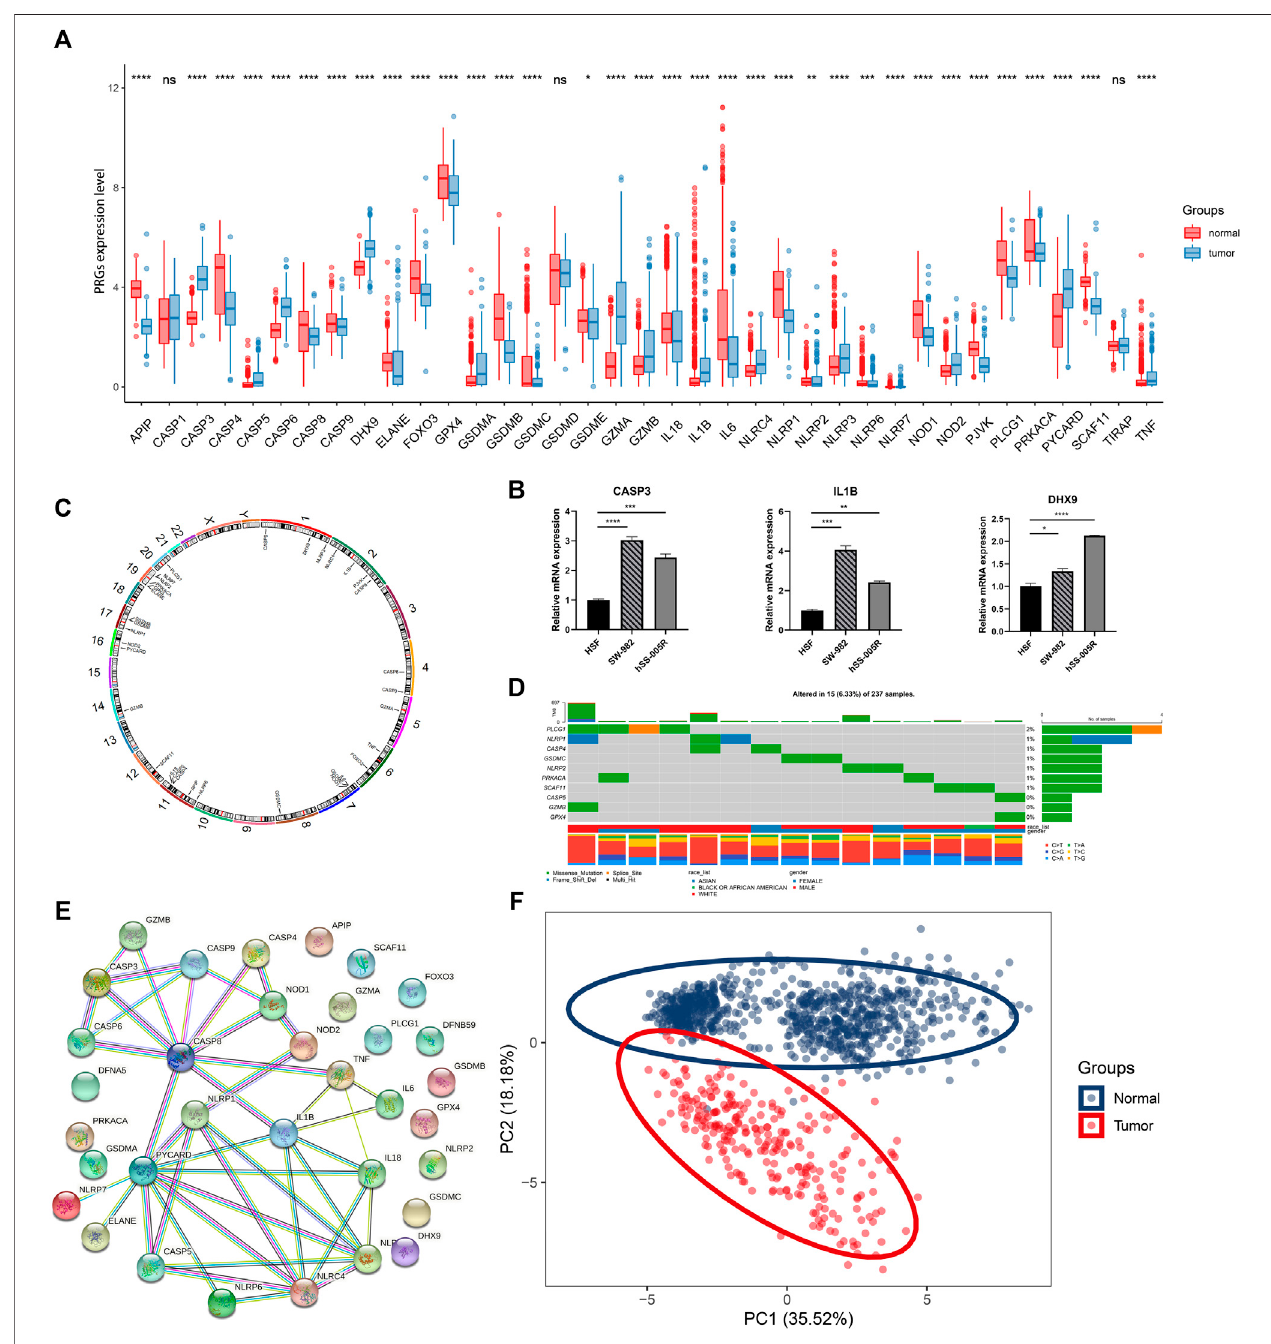
FIGURE 2 | Expression and association of PRGs. (A) The expression of PRGs between STS (blue) and normal tissues (red). Box plot represents the median (center horizontal line), upper and lower quartiles (top and bottom horizontal line). (B) Validation of mRNA expression of key PRGs in cell lines. (C) The location of PRGs on chromosomes. (D) Schematic overview of mutation frequency and type in PRGs. (E) PPI network constructed by PRGs-encoded proteins (interaction score: 0.9). (F) Principal component analysis (PCA) for discriminating STS and normal tissues based on PRGs. * p < 0.05, ** p < 0.01, *** p < 0.001, **** p < 0.0001, ns: nonsigni fi